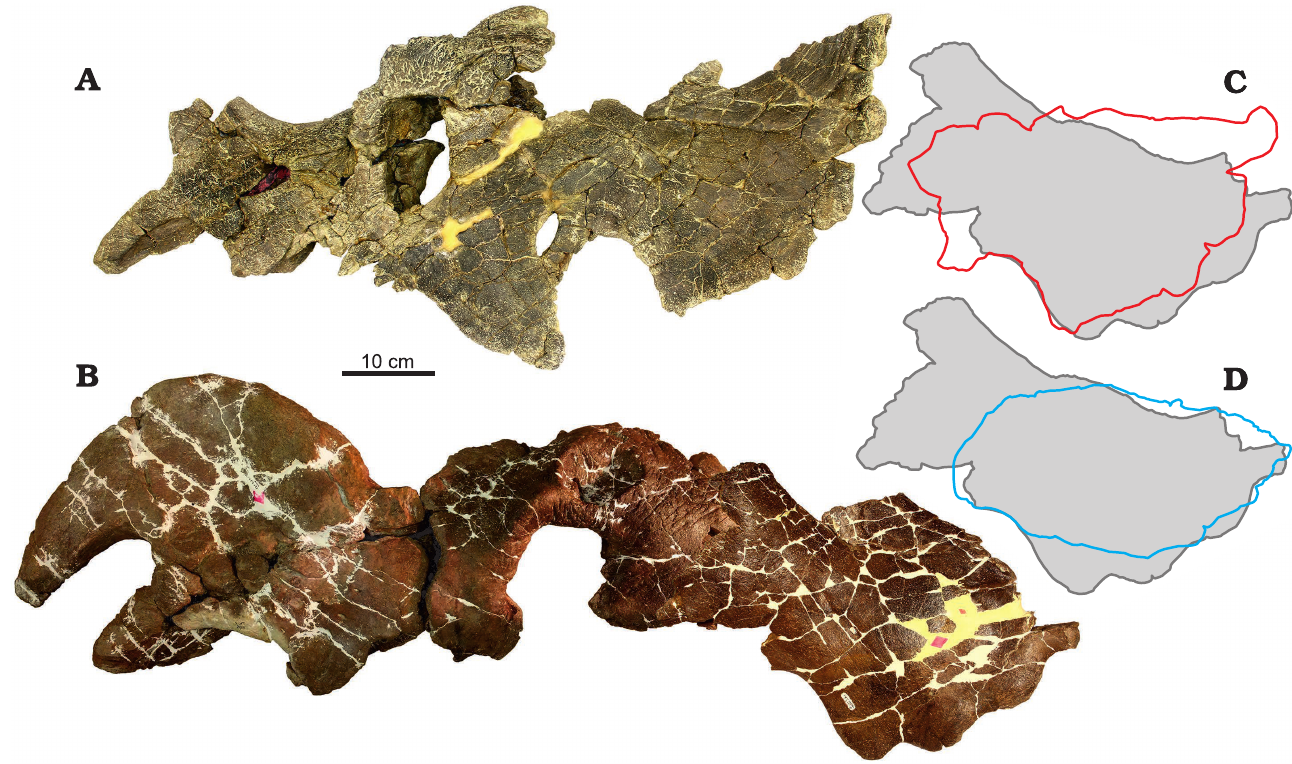
Fig. 8. Size comparison of squamosal versus face in Einiosaurus procurvicornis Sampson, 1995, subadult MOR 456 8-8-87-1 ( A ) and MOR 456 8-9-6-1, ho- lotype ( B , mirrored); squamosal superimposed in B. C . Outline of MOR 456 8-8-87-1 (red) superimposed over outline of MOR 456 8-9-6-1 (grey). D . Outline of MOR 591 (blue) superimposed over outline of MOR 456 8-9-6-1 (grey). Outlines aligned by otic